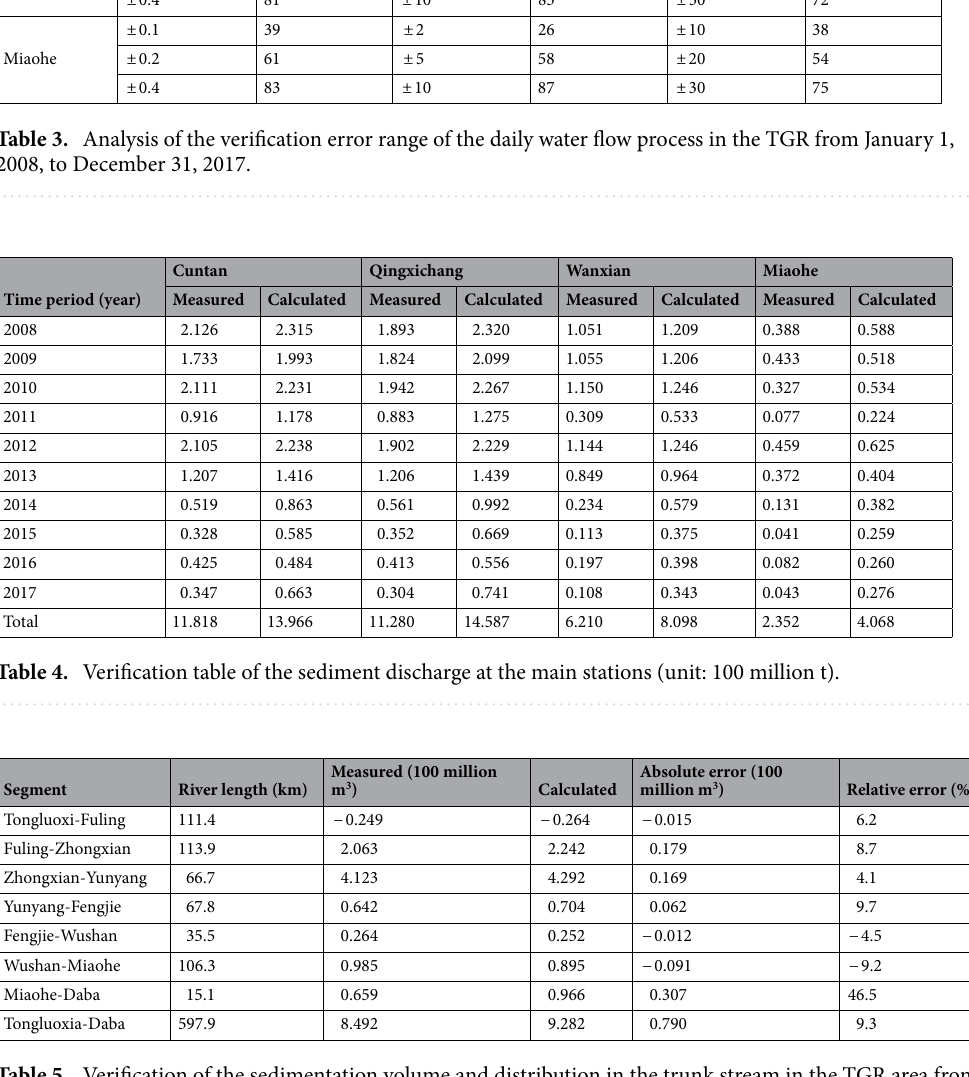
Table 5. Verification of the sedimentation volume and distribution in the trunk stream in the TGR area from 2008 to 2017 (based on the